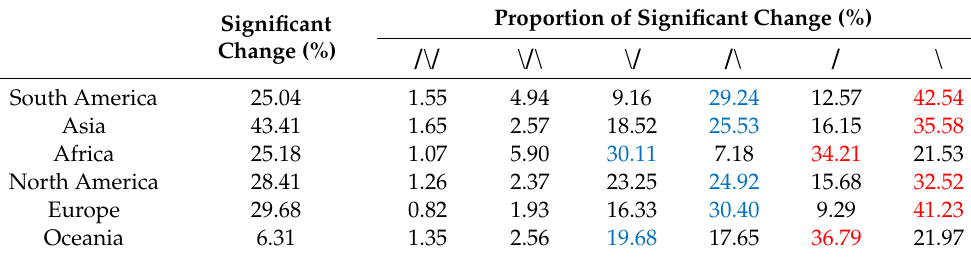
Table 1. Statistic of significant change in each continent.